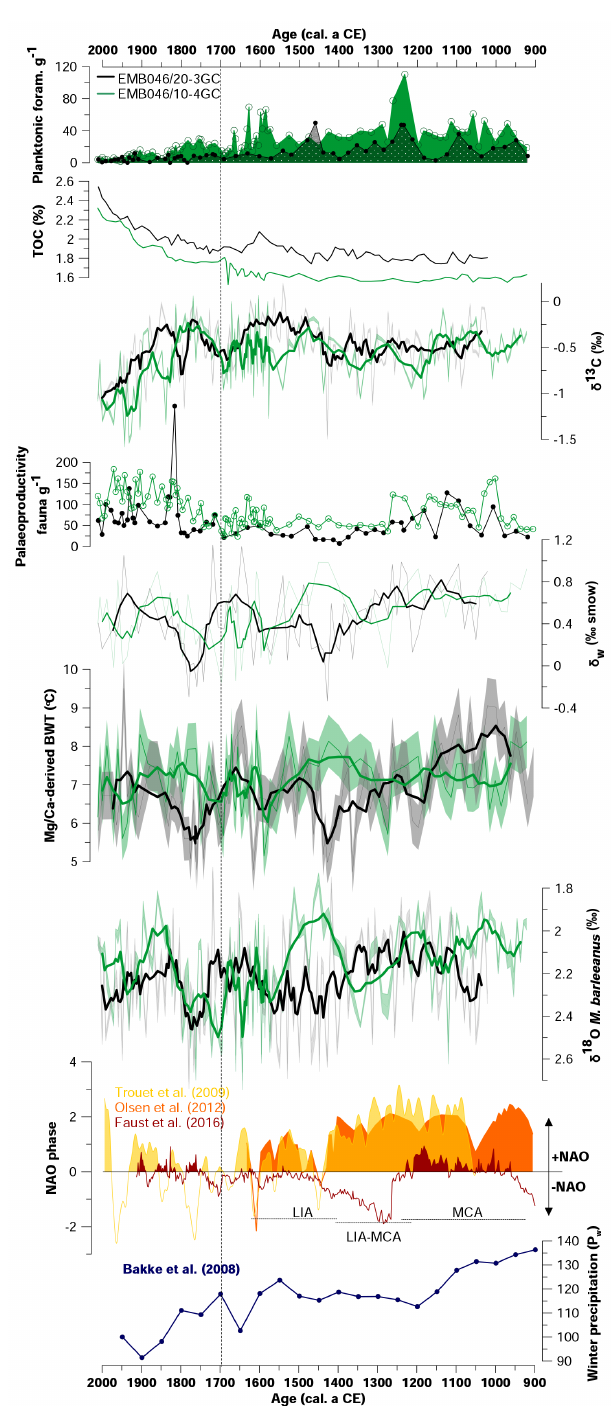
Figure 5. Comparison of absolute abundances of planktonic foraminifera, total organic carbon (TOC), stable carbon isotope ( δ 13 C), absolute abundance of palaeoproductivity fauna, the CABFAC results, stable oxygen isotope composition of seawater ( δ w ), Mg / Ca-derived bottom water temperature (Mg / Ca-derived BWT), and stable oxygen isotopes ( δ 18 O) of the two studied sediment cores EMB046/10-4GC (green curves) and EMB046/20-3GC (black curves). Reconstructions of the NAO index (yellow curve – Trouet et al., 2009, orange curve – Olsen et al. (2012), red curve – Faust et al., 2016) and winter precipitation (blue curve – Bakke et al. (2008)). The thicker curves correspond to a five-point running average. The errors bands represent uncertainties of the records. Dashed line divide record into two periods of the most pronounced palaeoproductivity changes, which are discussed in the